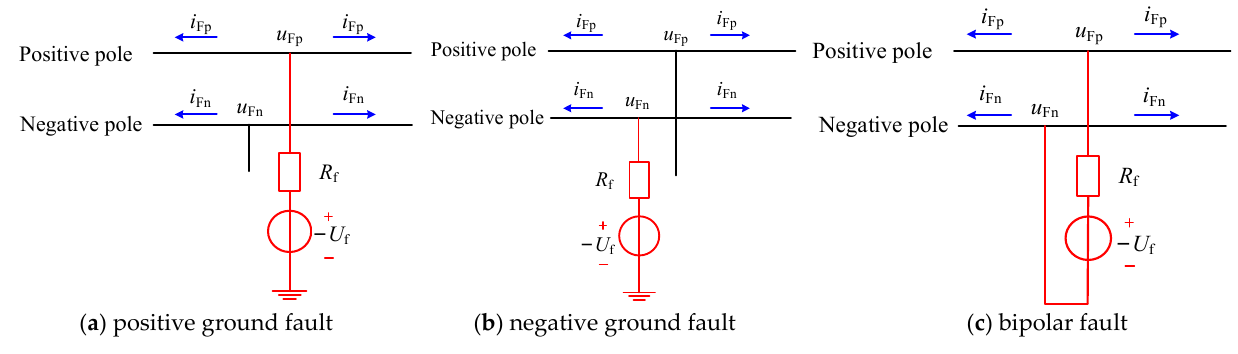
Figure 2. The structure of the overhead line tower of the Zhangbei flexible DC power grid. The bipolar DC system is taken as an example to analyze its fault traveling wave characteristics under a single ‐ pole ground fault and double ‐ pole ground fault. Figure 3 shows the fault network diagram of the system at the fault point, in which R f is the fault transition resistance.